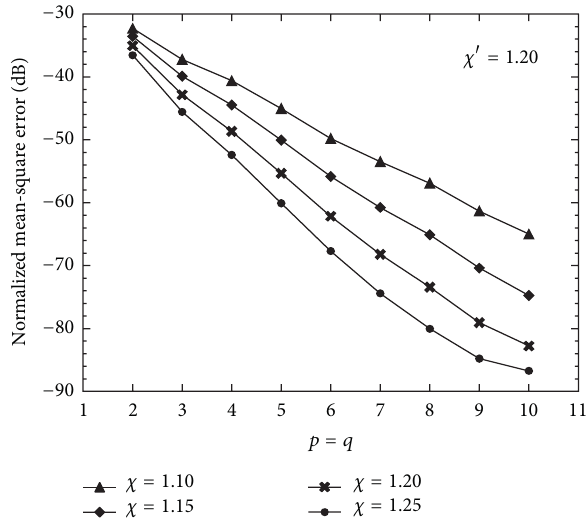
Figure 11: Normalized mean-square errors in the reconstruction of 𝑉